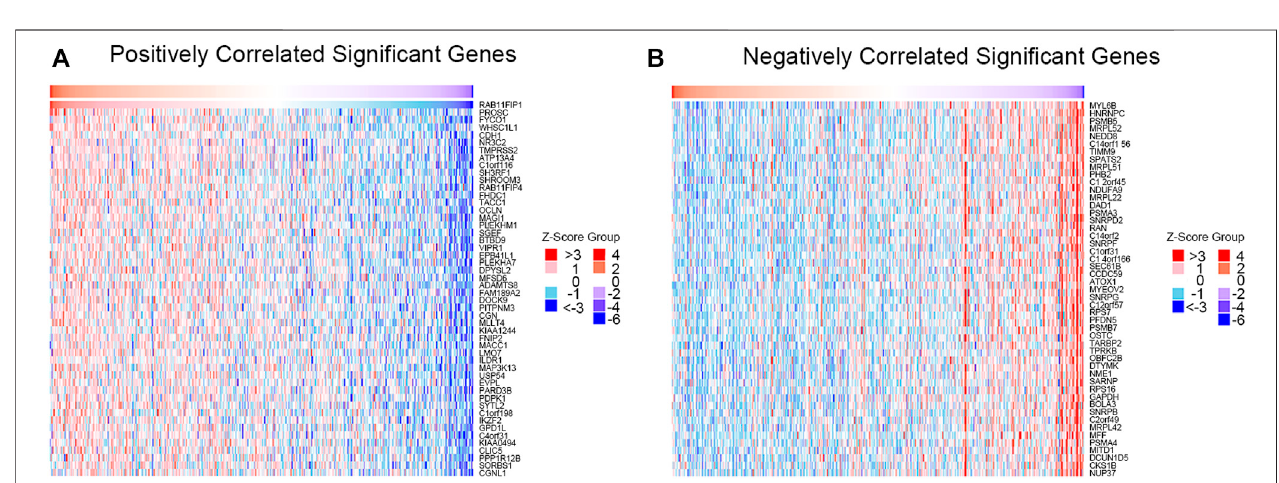
FIGURE 5 | Correlation between gene differential expression and RAB11FIP1 in LUAD. (A, B) Heat maps show positive and negative genes associated with RAB11FIP1 in lung cancer (top 50). Red is a positive gene correlation; green is a negative gene correlation.